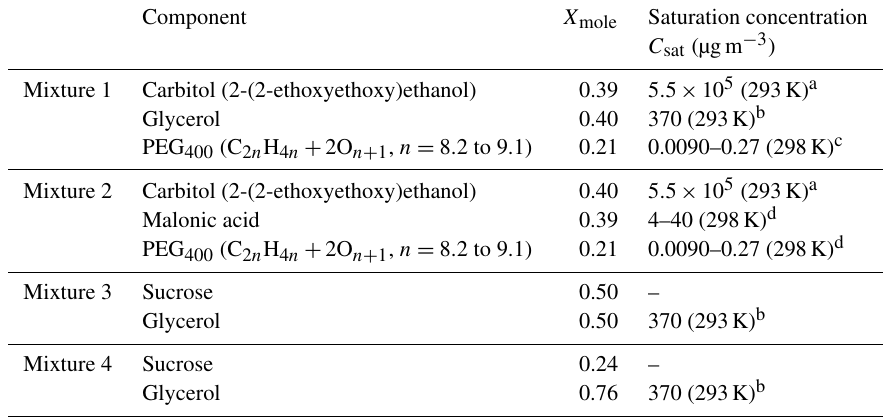
Table 4. Composition of mixtures 1–4 in EDB measurements and the literature values for the saturation concentrations. Component